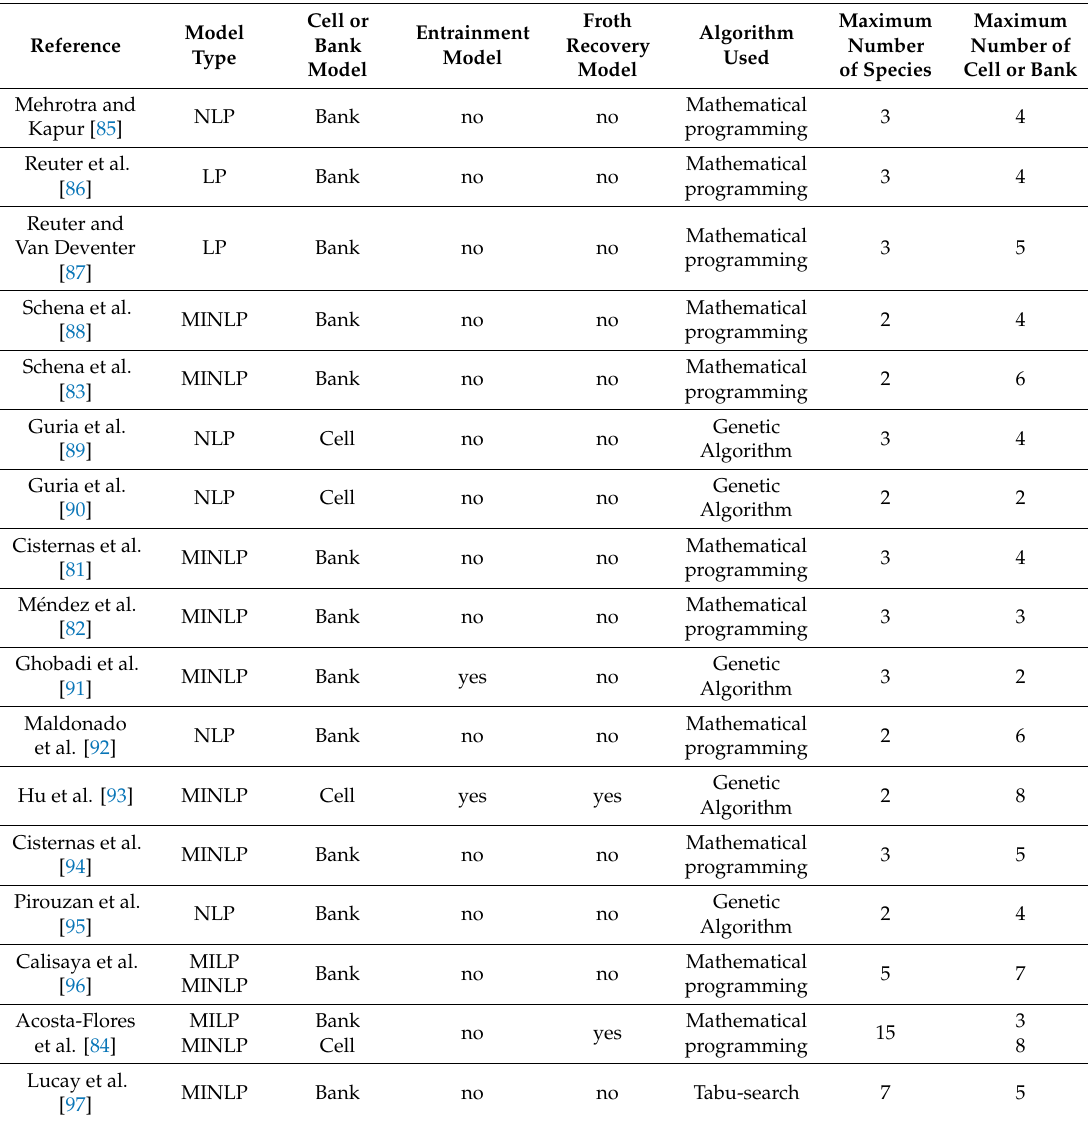
Table 1. Flotation circuit design methodologies (adapted from Reference [84]) (LP linear programming; NLP nonlinear programming; MILP, mixed-integer linear programming; MINLP, mixed-integer nonlinear